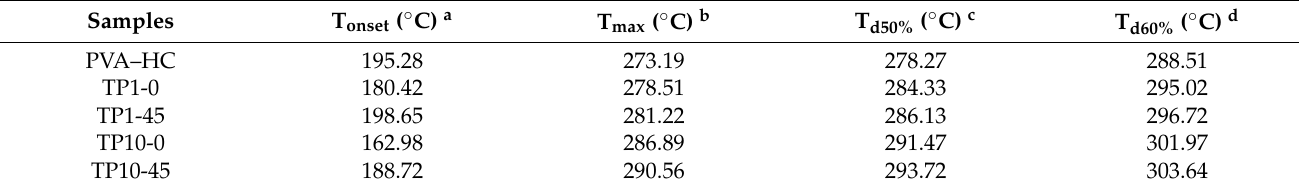
Figure 5. ( a ) TGA of different mass ratios of PVA-HC/TP under different ultrasonic duration; ( b ) DTGA different mass ratio of PVA-HC/TP under different ultrasonic duration. Table 1. Thermal characteristics of obtained